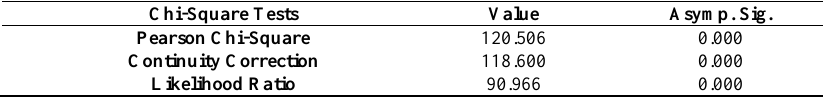
Table 7. Test of independence of variables “being an outlier” and “being a non- prosperous company”